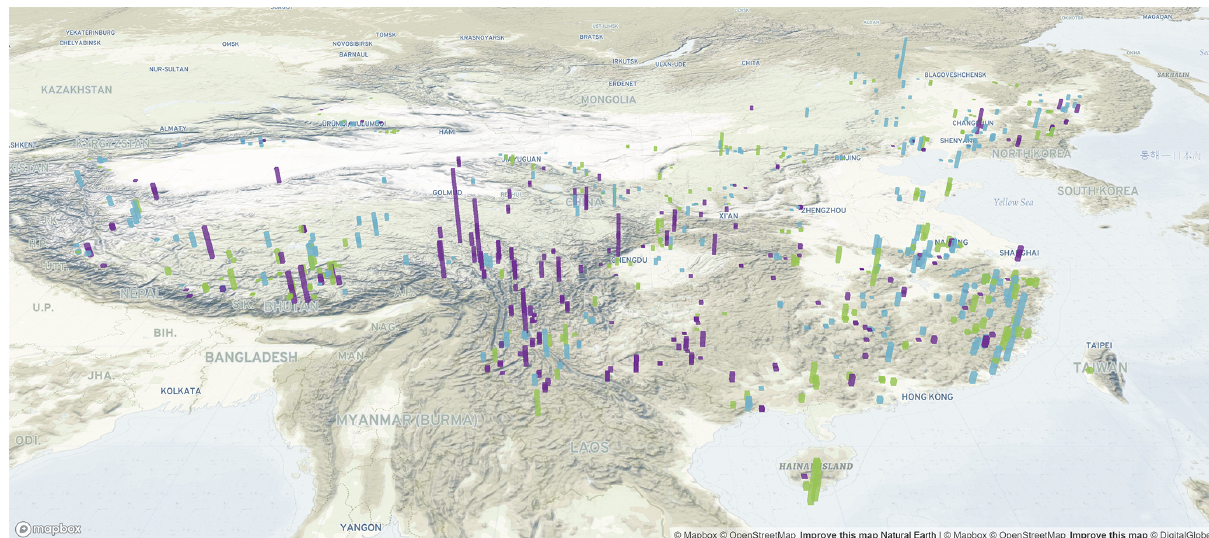
Figure 5. A screenshot of a three-dimensional bar graph visualizing the Mesozoic stratigraphic formations from China. Data are from the Geobiodiversity Database (GBDB). The colours of the bars are based on those in the International Chronostratigraphic Chart: Triassic (purple), Jurassic (blue), and Cretaceous (light green). The map is from © OpenStreetMap contributors, 2020. Distributed under a Creative Commons BY-SA License. The website of this graph is http://geobiodiversity.com:8080/download/xuhonghe/diagram/3dbar/index.html (last access: 1 November 2020). The code of this module is at